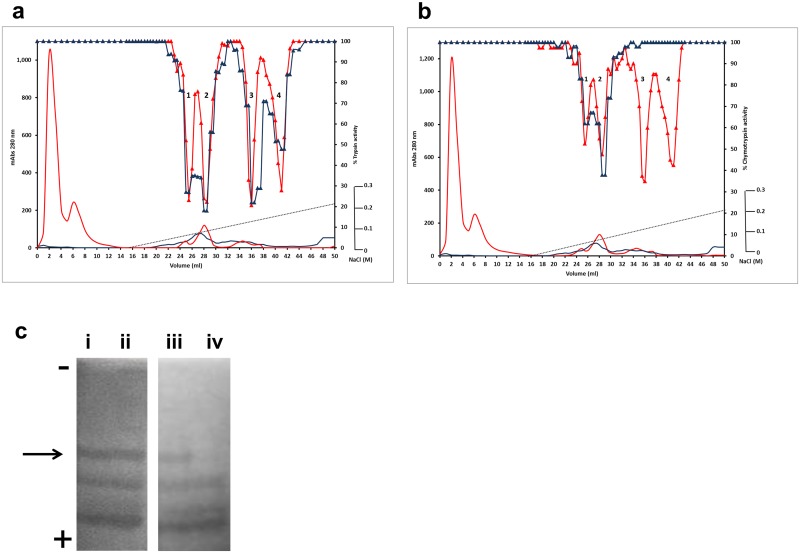
Enzyme inhibitory profile of the TI1 S85F mutation.Seed proteins from wild-type and mutant lines from the TI1 S85F family were separated by cation-exchange chromatography. Absorbance profiles at 280 nm are shown (a, b: red and blue lines without symbols; mAbs, left-hand scale). Using BAPNA and BTEE as specific substrates, the trypsin (a) and chymotrypsin inhibitory (b) activities of wild-type (red triangle) and mutant (blue triangle) protein fractions are shown, relative to assays where trypsin activity is 100% (control; right-hand scale). Numbers in peaks in each chromatogram correspond to the different forms of TI1 and TI2 (peak 1: TI2 processed; Peak 2: TI2 unprocessed; Peak 3: TI1 processed; Peak 4: TI1 unprocessed. (c) in-gel protease inhibitory activity of inhibitor isoforms from wild-type (i, iii) and S85F mutant (ii, iv) lines. Zymogram blue casein gels were treated with the digestive enzymes, trypsin (i, ii) or chymotrypsin (iii, iv); dark areas indicate where the enzyme has been inhibited. The direction of electrophoresis on non-denaturing gels is indicated (-, +). The arrow indicates the position of the isoform that is missing from the mutant lines (track iv).